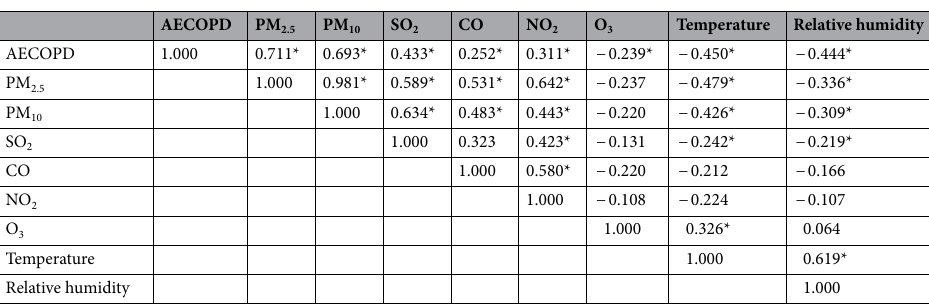
Table 2. Spearman correlation coefficients of the AECOPD cases with air pollutants and meteorological factors. * p < 0.05.